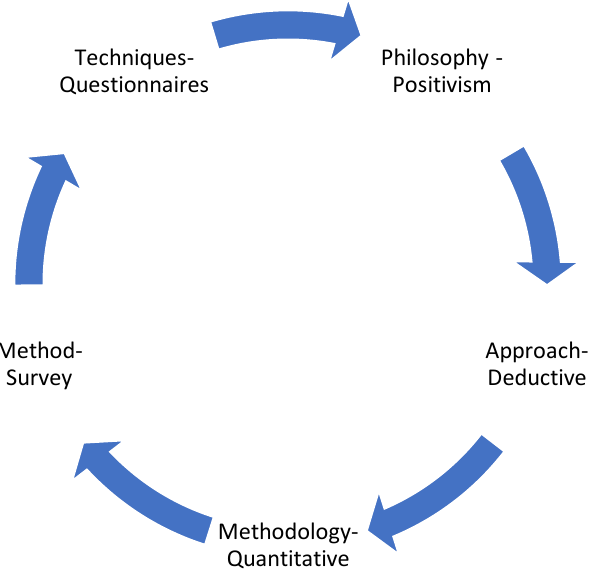
Figure 3. An overview of the chosen Research Philosophy Approach.